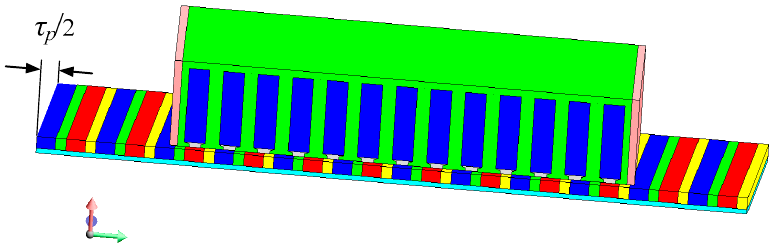
Figure 9. Schematic of the use of skewed magnets for cogging force reduction in a linear machine.